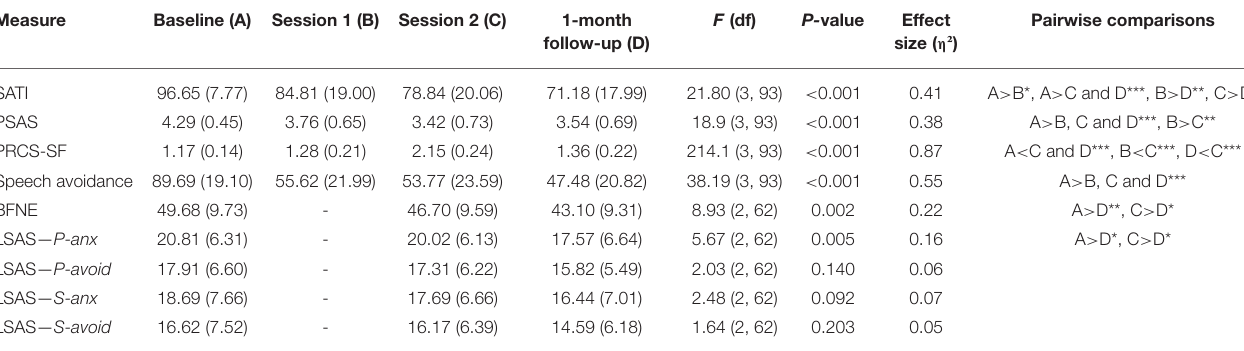
TABLE 3 | Change in PSA from baseline, to Session 1, Session 2 and one-month follow-up.